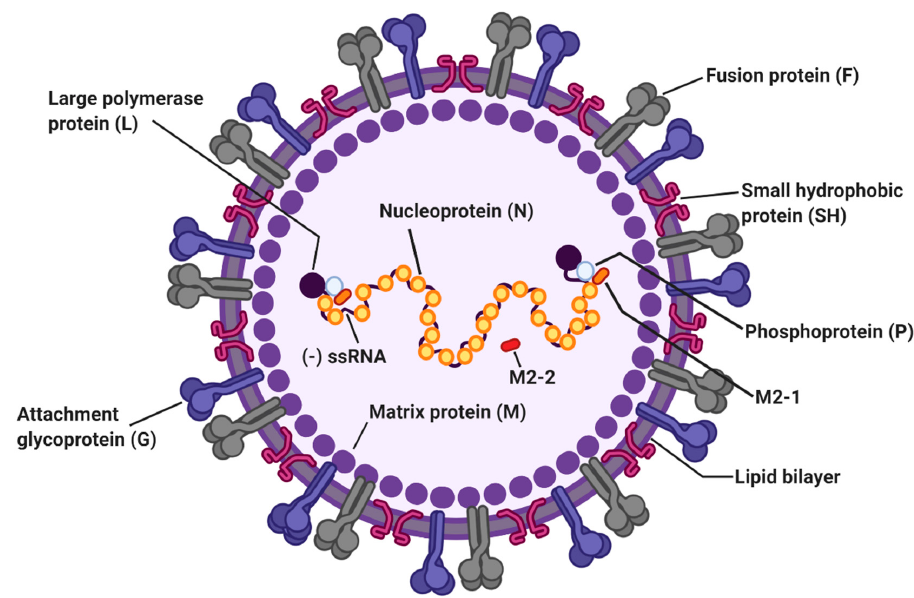
Figure 1. The structure of respiratory syncytial virus (RSV). The RSV genome is 15.2 kb of nonsegmented negative-sense RNA encoding 11 viral proteins. Viral envelope of RSV contains three transmembrane glycoproteins: attachment glycoprotein (G), fusion protein (F), and small hydrophobic protein (SH). Matrix proteins (M) are present on the inner side of the viral envelope. Viral RNA is tightly encapsidated by nucleoproteins (N) and the large proteins (L), phosphoproteins (P), and M2-1 proteins that mediate viral RNA transcription. M2-2 protein regulates viral RNA synthesis .